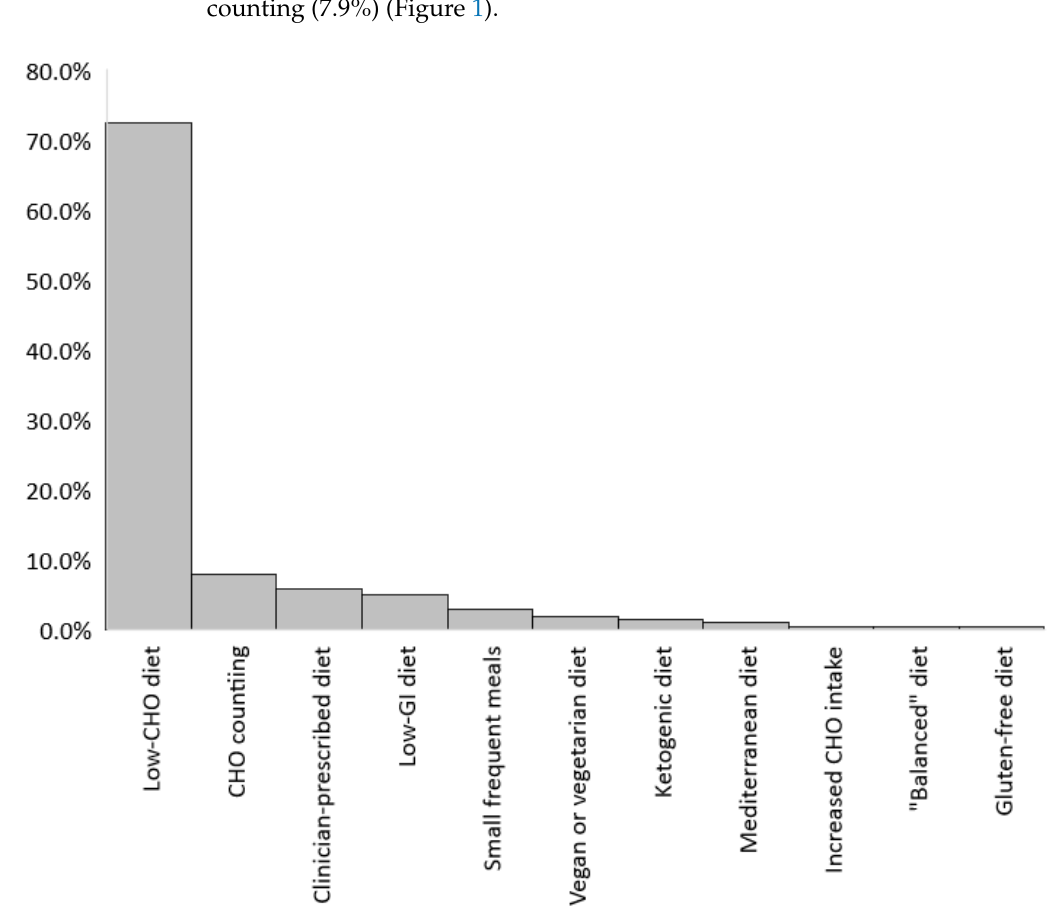
Figure 1. Speci fi c diets followed during pregnancy ( n = 202). Figure 1. Specific diets followed during pregnancy ( n =